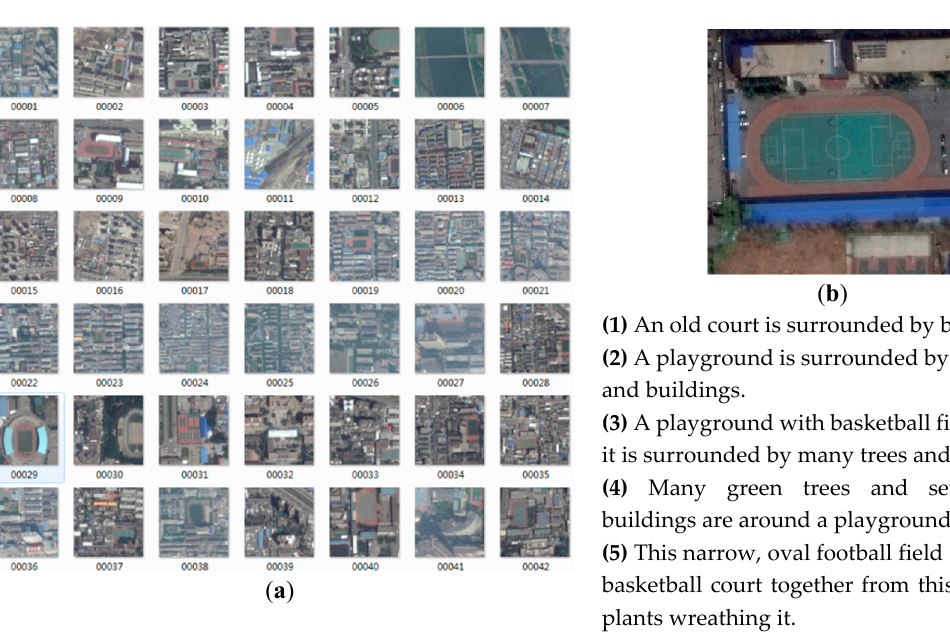
Figure 6. ( a ) Parts of images of RSICD; ( b ) An image of RSICD and its five captions.